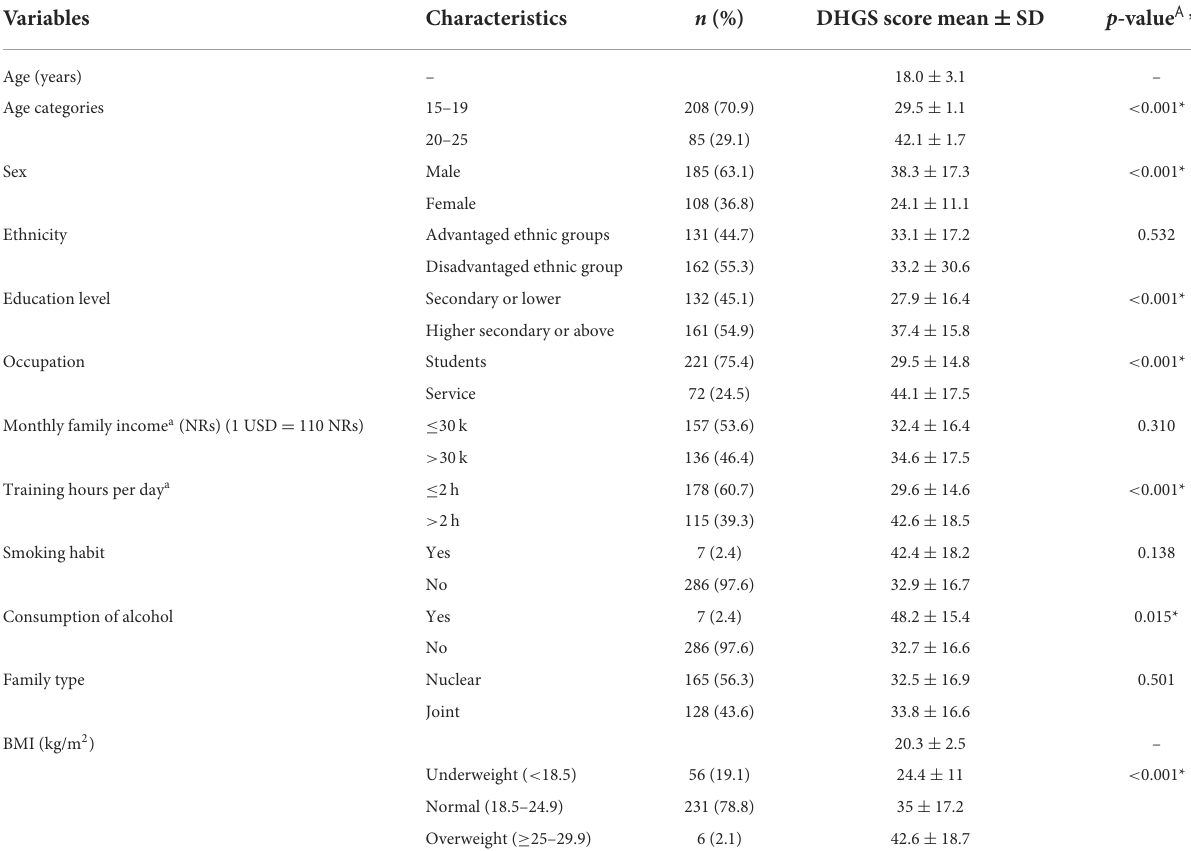
TABLE 1 Socio-demographic and anthropometric characteristics with DHGS score of the study participants ( n = 293).